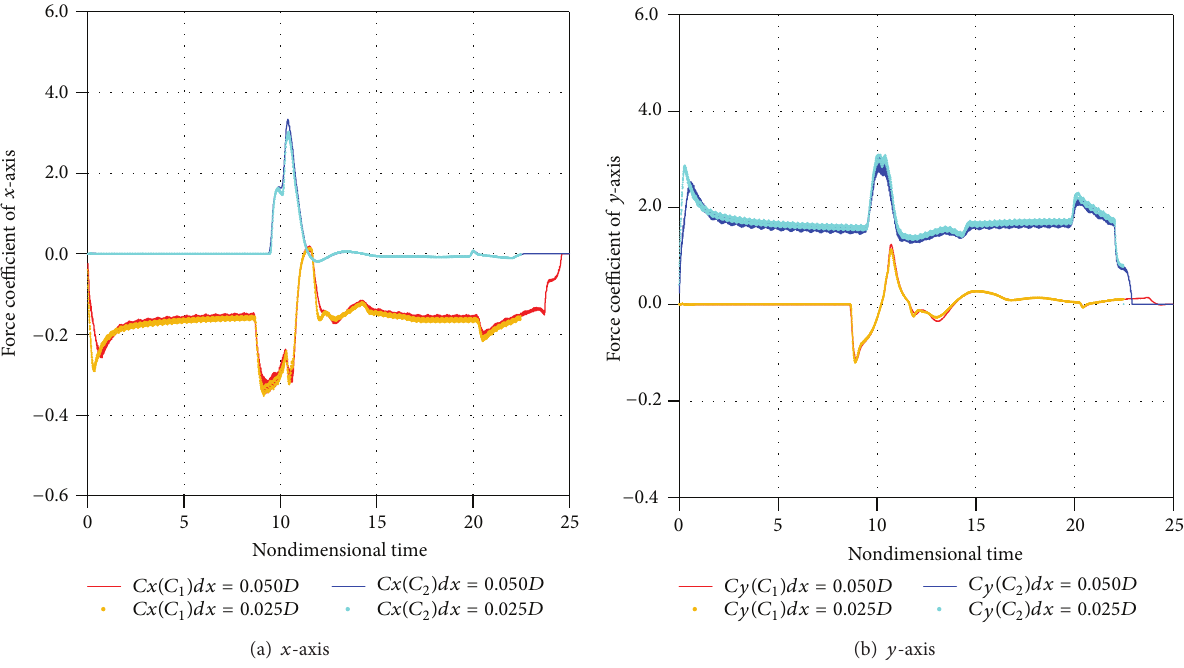
Figure 25: Temporal variation of axial force